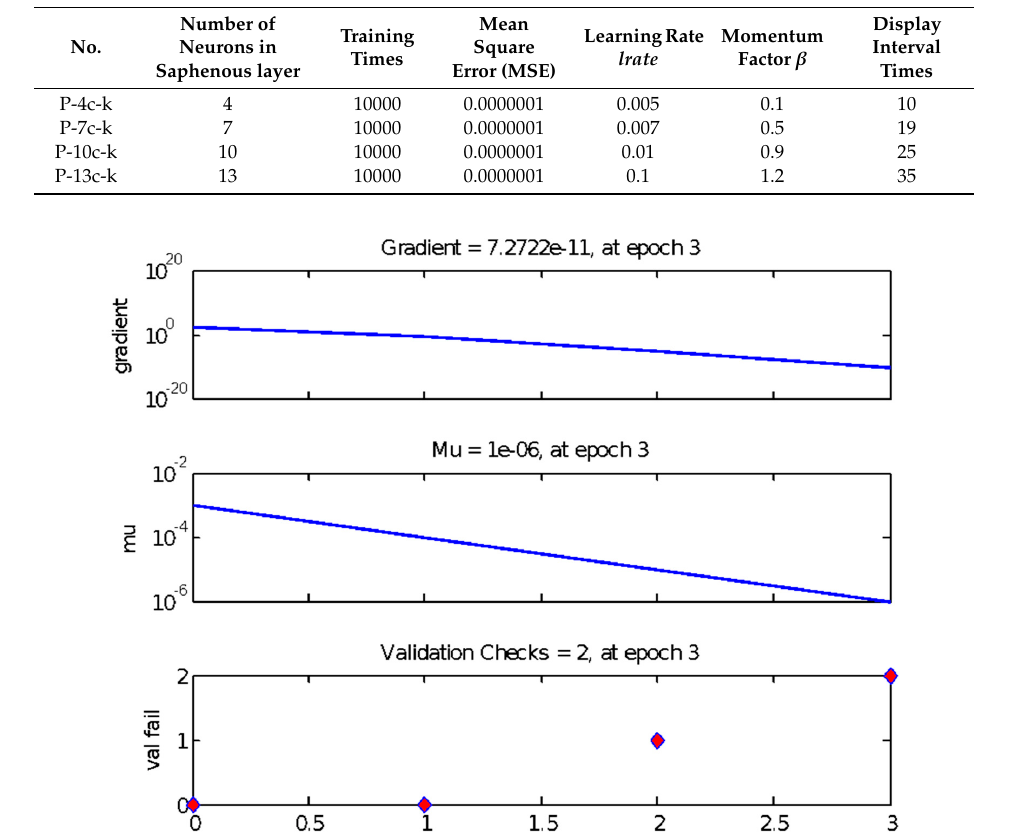
Table 7. The initial parameter setting of the model.